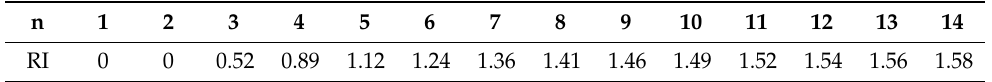
Table 3. Average random consistency